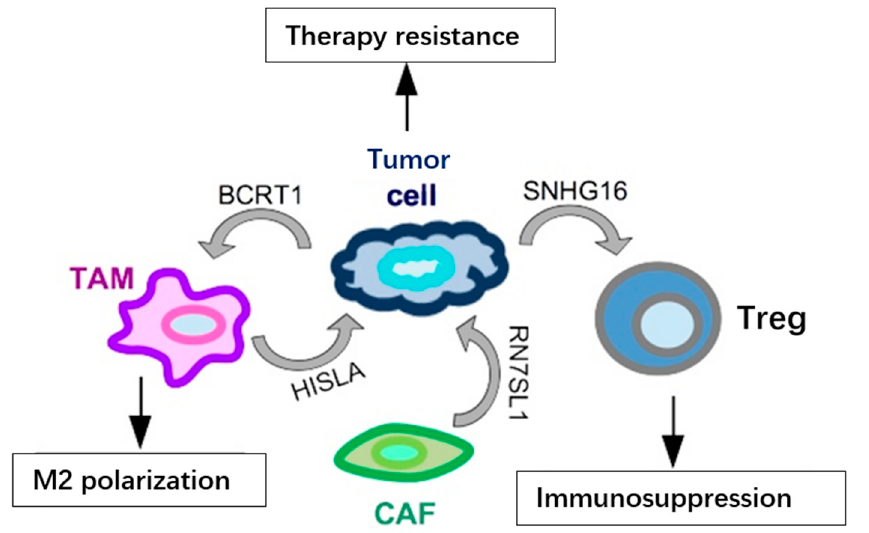
Figure 3. Examples of lncRNAs secreted in exosomes by cells in the TME and their functional output in TNBC. LncRNAs (BCRT1 and SNHG16) may be secreted by cancer cells and impinge on the ac- tivity of other cell types in the TME, such as TAMs and Tregs, enhancing their pro-tumoral behavior. At the same time, various cells in the TME may release lncRNAs, such as HISLA and RN7SL1, in exosomes and reach tumor cells to increase their resistance to